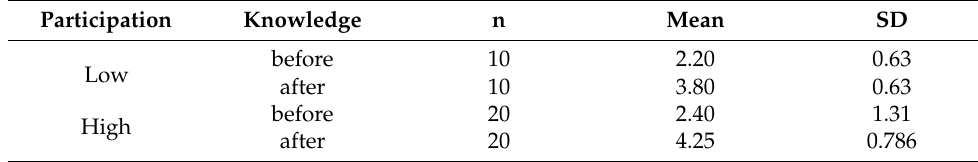
Table 3. Mean and standard deviation (SD) of knowledge scores in each group. Participation